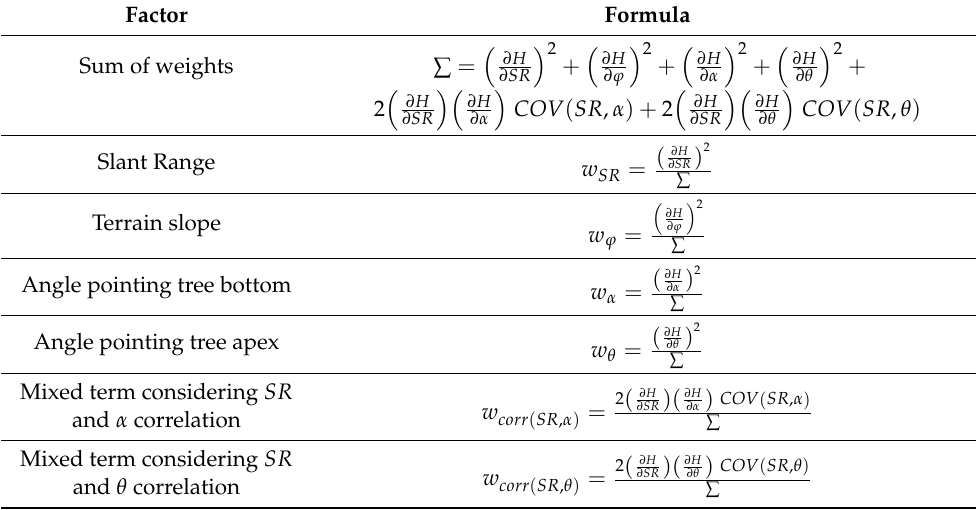
Table 3. Relative weights affecting variance of H